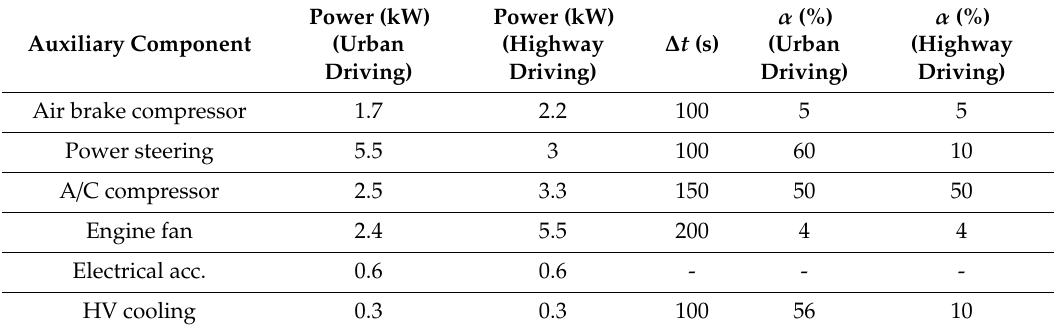
Table 4. Power and duty cycle parameters of the auxiliary loads in the hybrid HD powertrain. Power (kW) Power Auxiliary Component (Urban